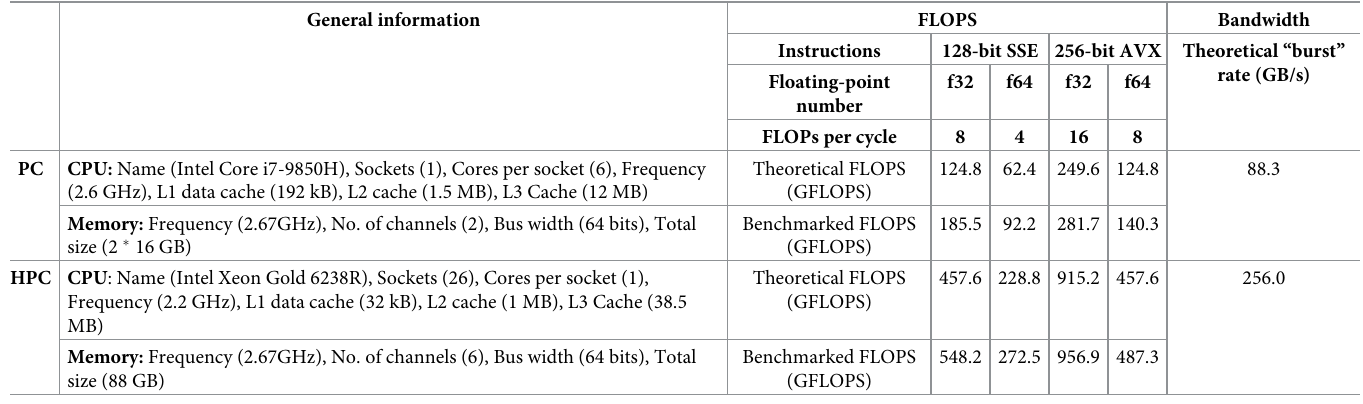
Table 3. Information of the tested CPU platforms.